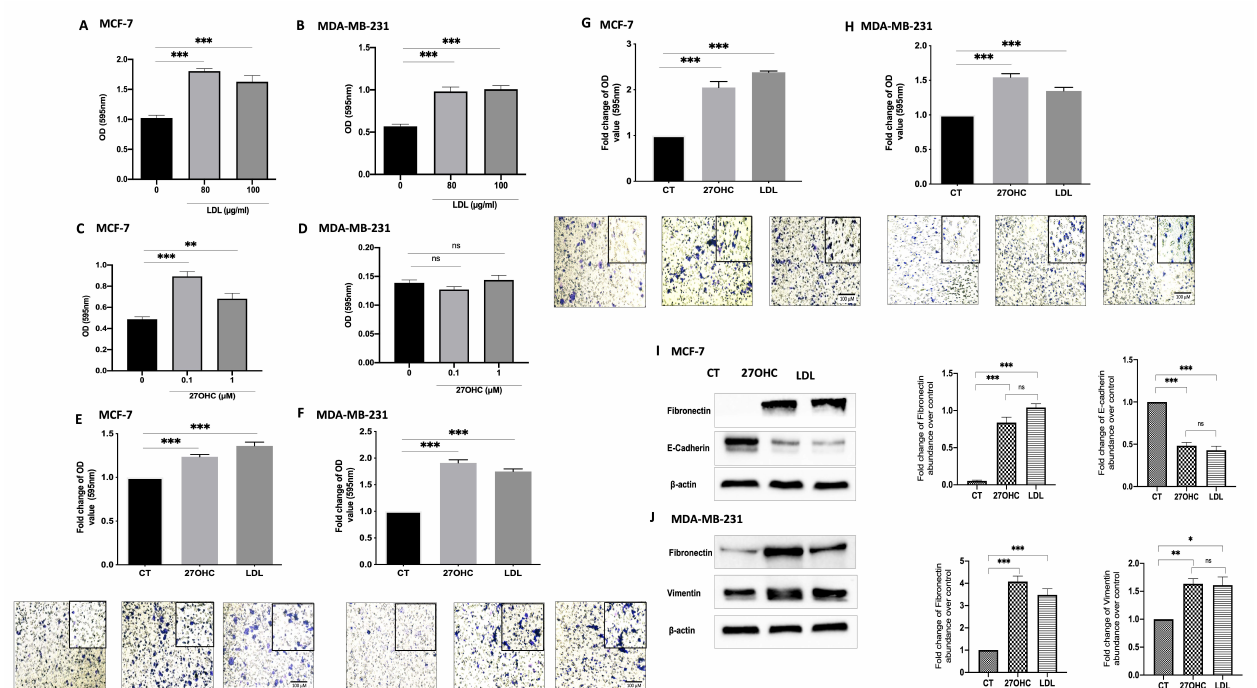
Figure 1. Effects of exogenous 27OHC and LDL on cell growth, migration/invasion, and EMT markers. Crystal violet staining proliferation assay results for ( A ) MCF-7 and ( B ) MDA-MB-231 after being dosed with LDL (80 and 100 µ g/mL) for 48 h and with 27OHC (0.1 and 1 µ M) for 48 h for ( C ) MCF-7 and ( D ) MDA-MB-231. A trans-well assay was used to detect cell migration and invasion after being dosed with LDL or 27OHC, the migrated cells were stained with crystal violet, and images were taken ( × 20 magnification). Quantification of ( E ) MCF-7 cell migration after a 24 h incubation period, ( F ) MDA-MB-231 cell migration after 6 h incubation period. Quantification of ( G ) MCF-7 cell invasion after 24 h incubation period and ( H ) MDA-MB-231 cell invasion after a 6 h incubation period. Western immunoblot analysis was performed to show the protein abundance of EMT markers, fibronectin, and vimentin, and their densitometric analyses were corrected in ( I ) MCF-7 and ( J ) MDA- MB-231 after being dosed with 27OHC (0.1 µ M) and LDL (80 µ g/mL). p -values were determined by (LSD) post-hoc test (* p < 0.05, ** p < 0.01, *** p <0.001). Scale bar represents 100 µ